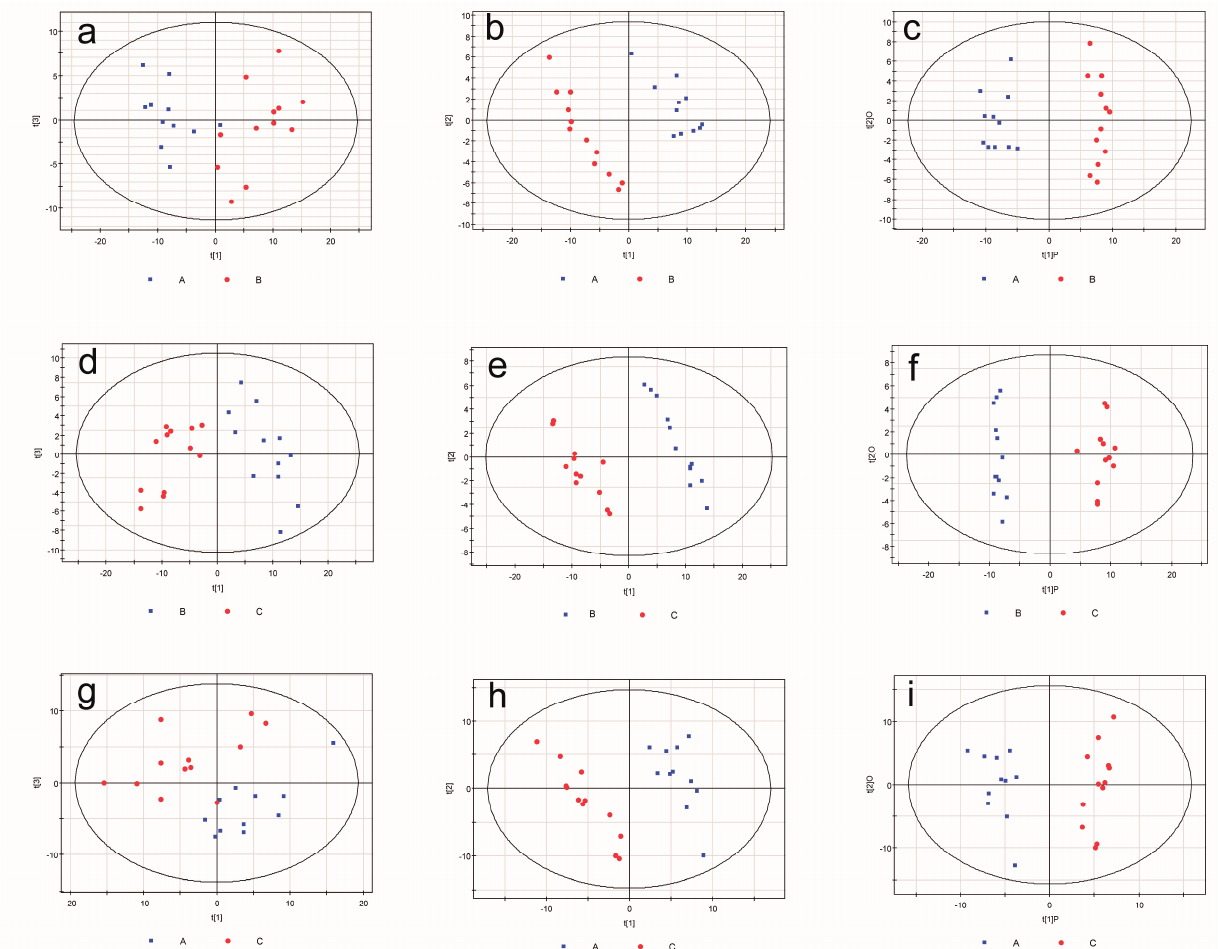
Figure 3. Multivariate statistical analysis. Principal component analysis (PCA) scores plot derived from GC–MS spectra of rat cortical neurons infected from ( a ) Hu-H1 and Strain V; ( d ) Strain V and non-infected control (CON); and ( g ) Hu-H1 and CON. Paired partial least-squares discriminant analysis (PLS-DA) model showing a clear separation between rat cortical neurons infected from ( b ) Hu-H1 and Strain V; ( e ) Strain V and CON; and ( h ) Hu-H1 and CON. Orthogonal partial least-squares discriminant analysis (OPLS-DA) model showing clear separation between rat cortical neurons infected with ( c ) Hu-H1 and Strain V; ( f ) Strain V and CON; and ( i ) Hu-H1 and CON. (A represents Hu-H1; B represents Strain V; C represents non-infected control